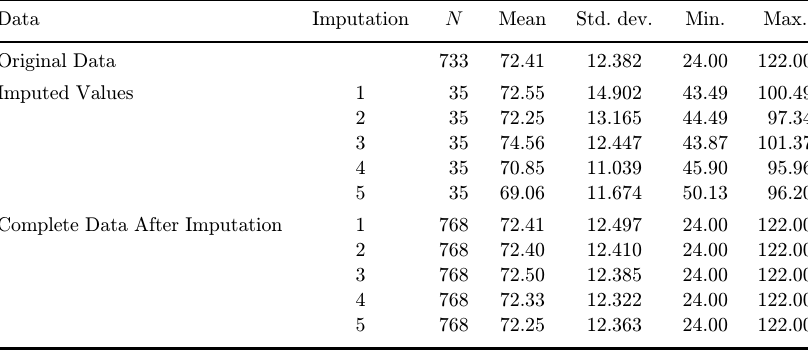
Table 3. Multiple imputations for V 3.